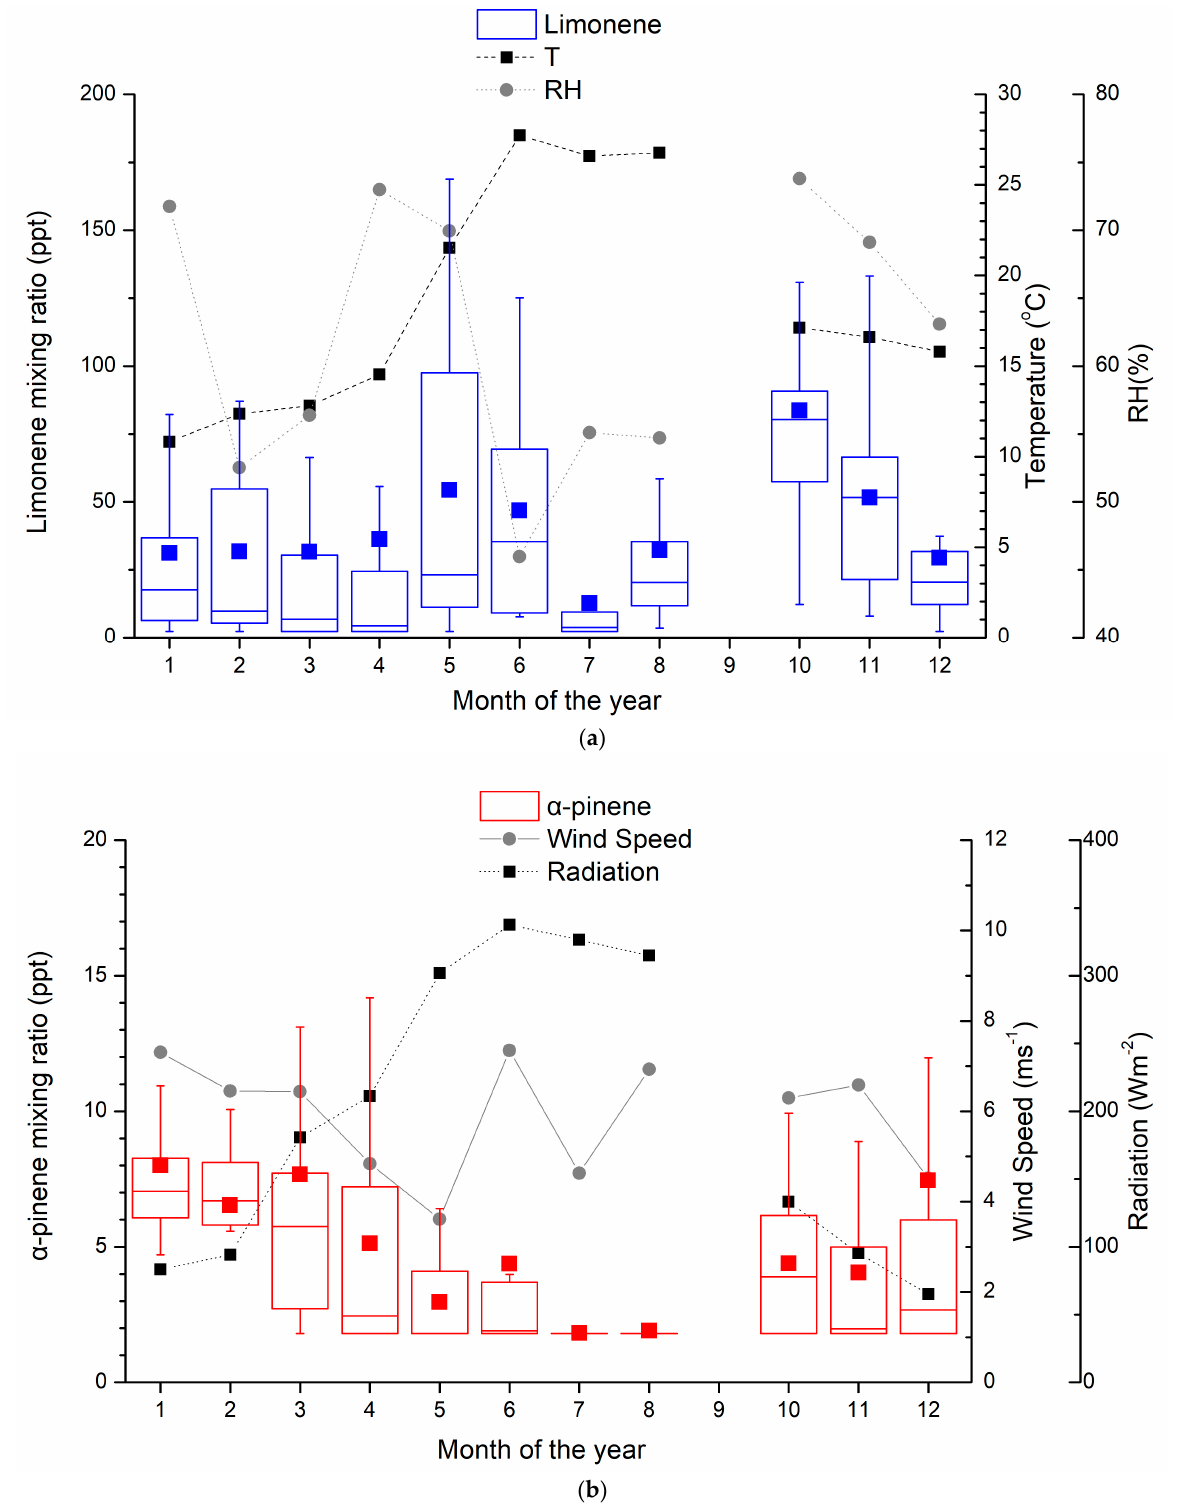
Figure 1. Monthly average mixing ratios (in ppt) of ( a ) limonene and ( b ) α -pinene at Finokalia station from March 2014 to April 2015. Whiskers represent the 5th and 95th percentiles, box edges are the 25th and 75th percentiles, the line in the box is the median, the square is the mean of the reported values, and the mixing ratio is in ppt. The meteorological parameters (temperature, relative humidity, wind speed and radiation), averaged over the days of the samplings, are also